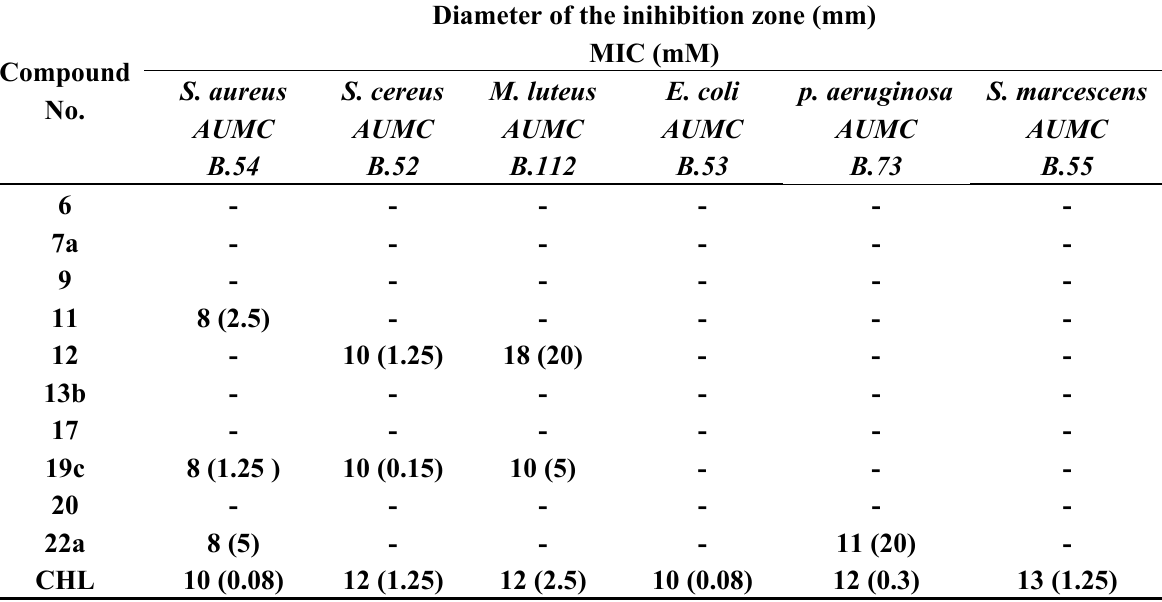
Table 1. Antibacerial activity data [inhibition zone in mm/MICs (in